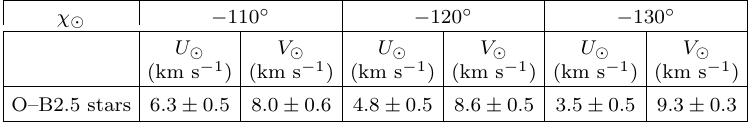
Table 3. Components of the peculiar velocity of the Sun with respect to the LSR, calculated taking into account the effects of both the differential Galactic rotation and the spiral density wave for different values of (cid:31) ⊙